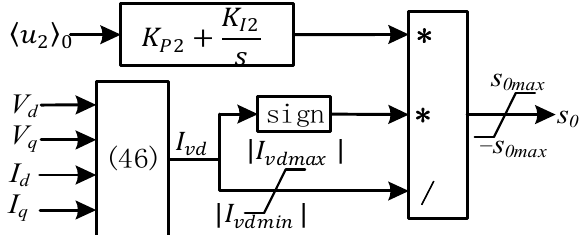
Figure 4. DC-side voltage balancing control when considering I vd